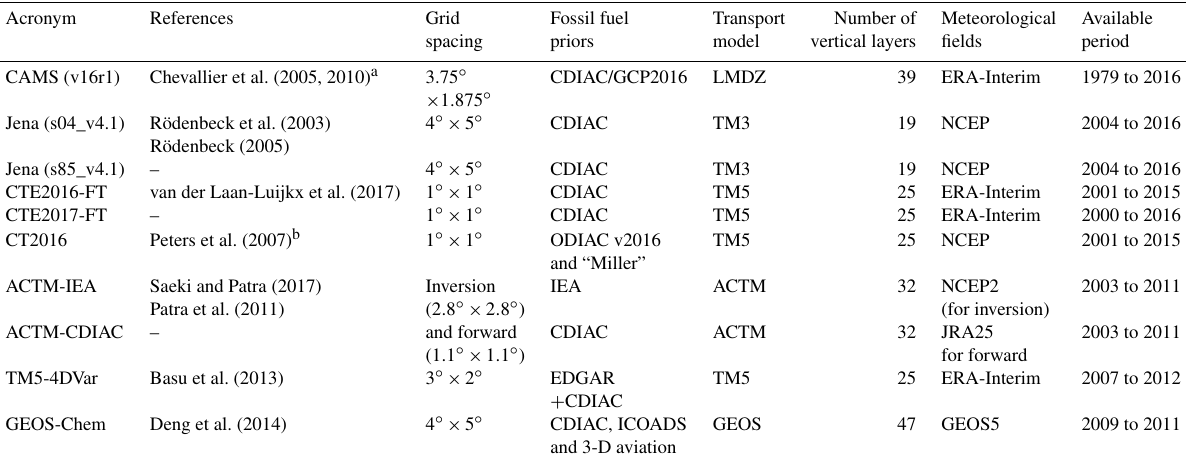
Table 1. List of the inverse modeling systems used in this study and general